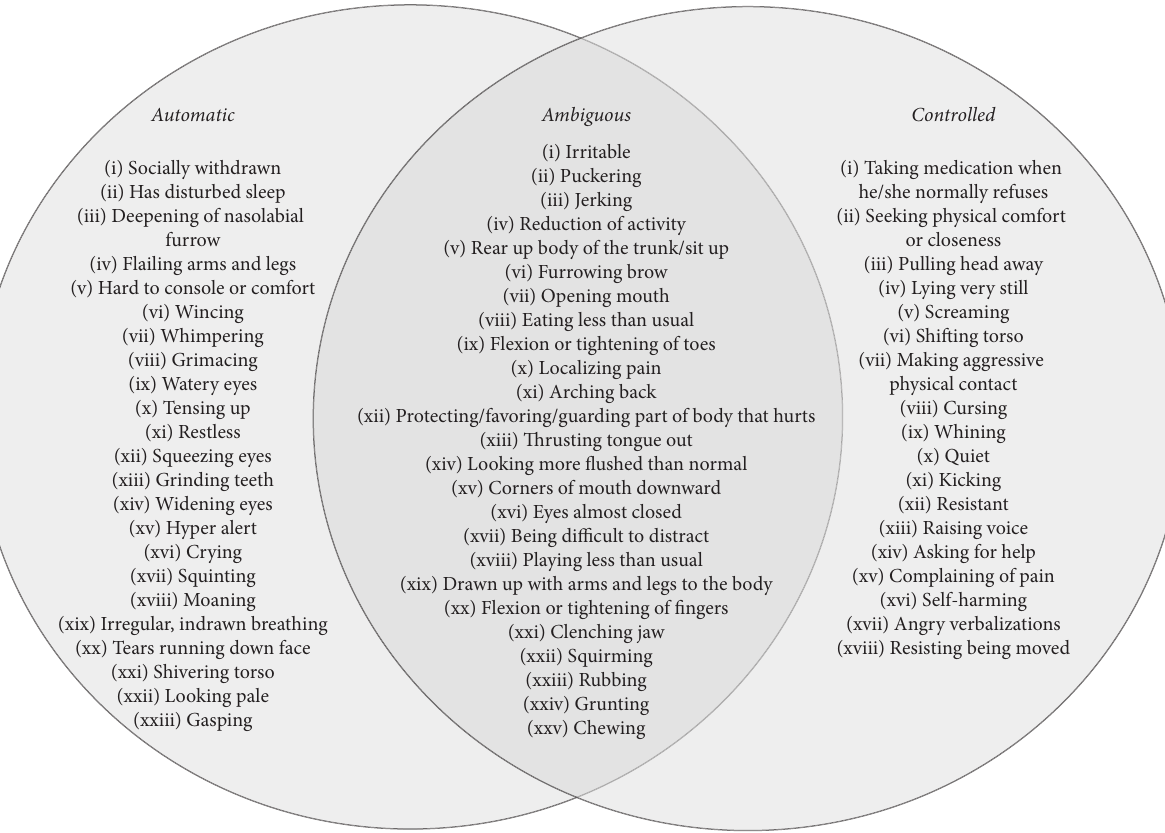
Figure 1: Pain behavior items categories according to the factor